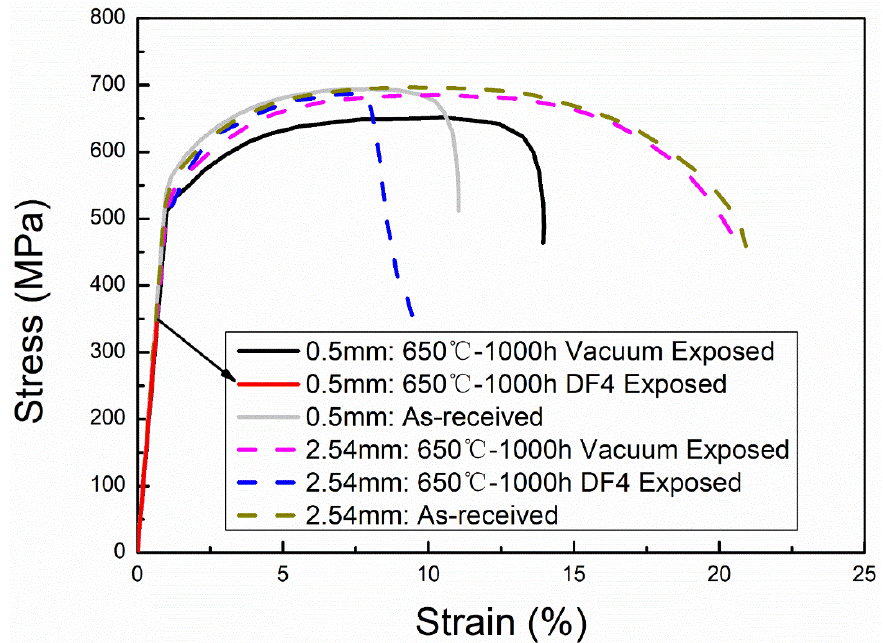
Figure 23. The engineering stress–strain curves obtained from the room temperature tensile testing on 2.54 mm/0.5 mm thick FMs P91 exposure to 650 °C vacuum or 650 °C/1 bar CO 2 containing 4 vol % H 2 O and 1 vol % O 2 (DF4) for 1000 h. The stress–strain curves of as-received samples are also shown. [34]. Reproduced with permission from Springer Nature.